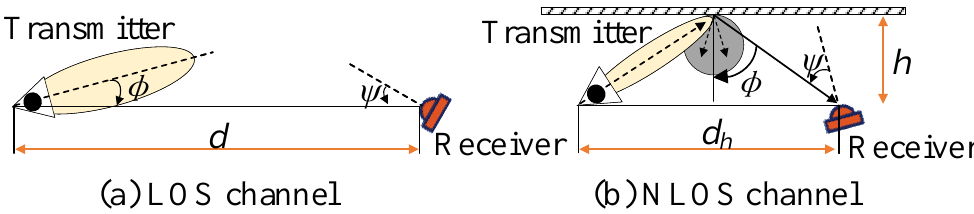
Figure 1. Theoretical model. Here d is the distance between the transmitter and the receiver and φ is the angle; ψ is the field of view (FOV) at the receiver; h is the distance between the receiver and the reflecting surface; and d h is the distance between the transmitter and the